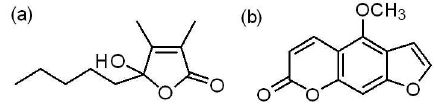
FIGURE 1 - Structures of hydroxydihydrobovolide (a) and IS